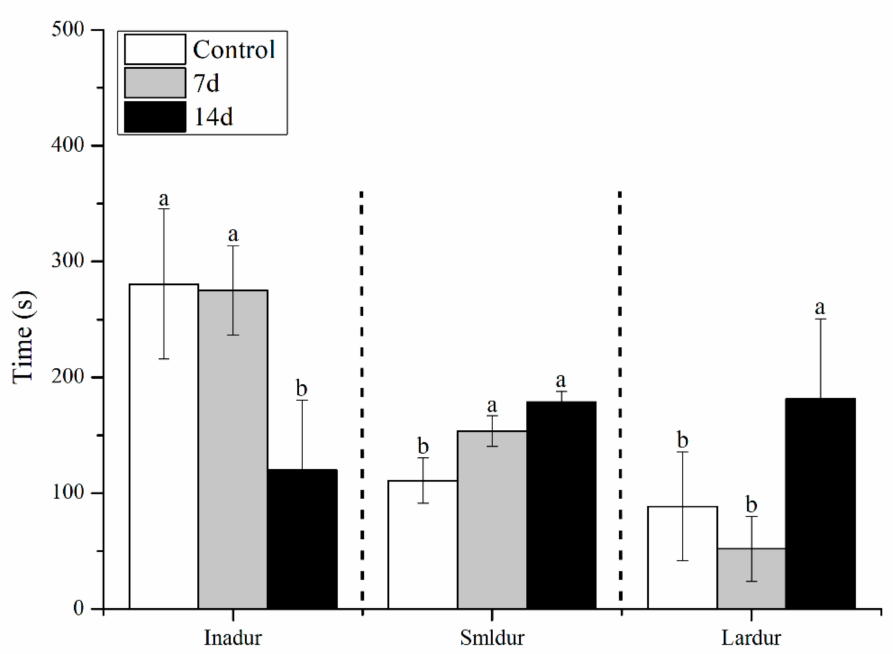
Figure 4. Effects of 7 and 14 days of the UCS protocol on inadur, smldur, and lardur in the rare minnow. Data are expressed as mean ± SE (n = 18). The different letters in the bar indicate significant differences between the two groups ( p <